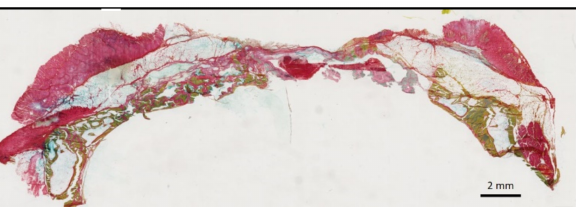
Figure 9. Histologic view of calvaria defects at 8 weeks showing—( left ) the IPN group, with the defect mainly occupied by the bone graft material and the newly formed bone, and ( right ) the control empty group, with the defect mainly occupied by soft tissues, which collapsed inside the defect, and limited new bone formation at the defect boundaries.